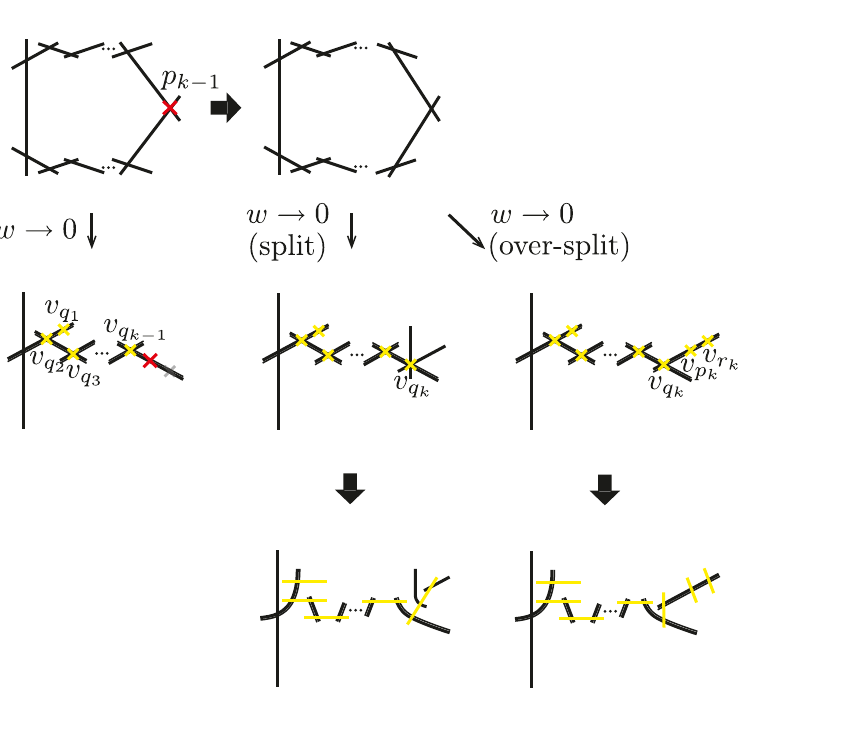
Figure 2 . Singularities and exceptional curves in a split and an over-split I 2 k +1 model for k ≥ 2 near a double root of c 2 = 0 1 , 0